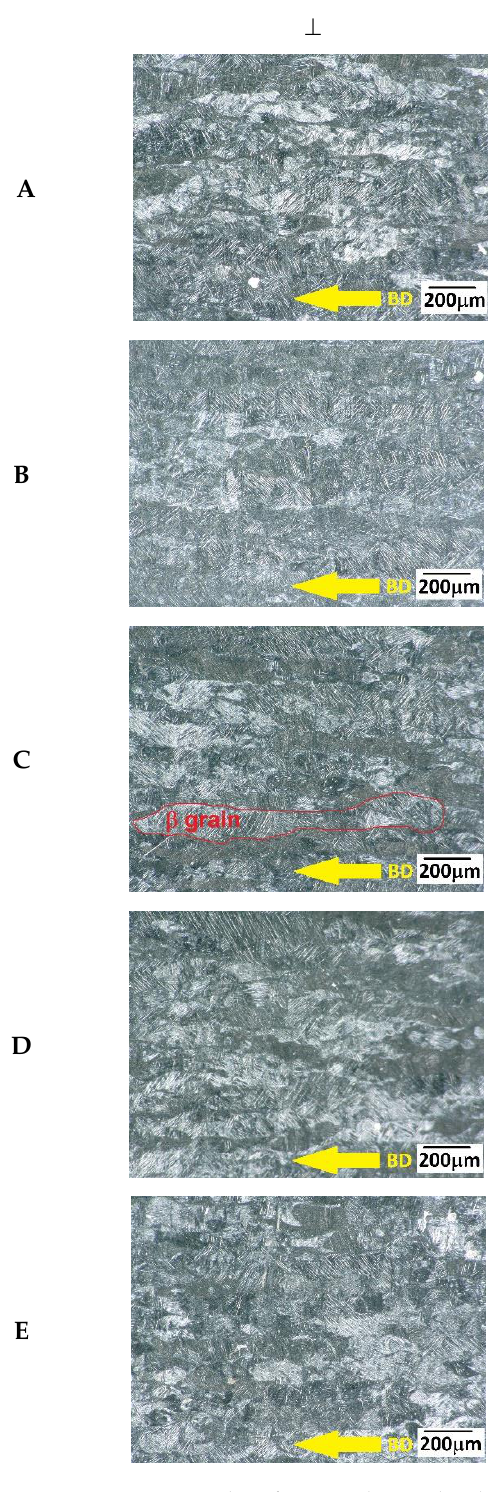
Figure 3. Micrographs of material in individual positions ( A – E ) and directions ( ⊥ and ‖ ), light microscope (LM), the arrow indicates build direction (BD).